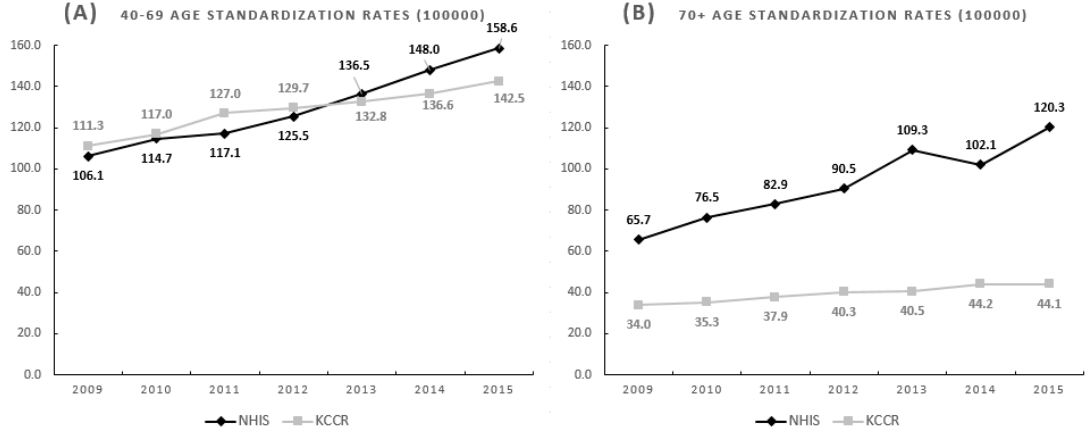
Figure 3. Age-standardized NHIS (detection rate) and KCCR (incidence rate) of breast cancer, 2009 to 2016. ( A ) 40–69 years of age, NHIS vs. KCCR; ( B ) ≥ 70 years of age, NHIS vs. KCCR. NHIS, National Health Insurance Service; KCCR, Korea Central Cancer Registry.